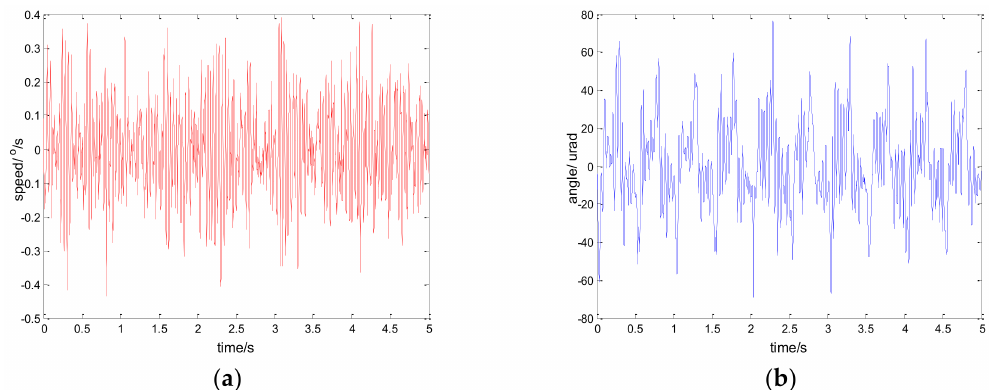
Figure 20. Experiment results of robust SMC with NTD. d = sin ( 2 π × 2 t ) : ( a ) speed; and ( b ) tracking error, RMS = 23.0459 urad.